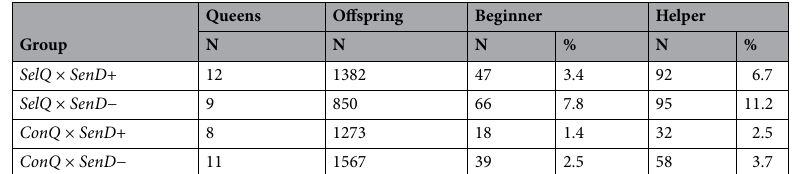
Table 1. Grouping considering queen’s origin and drone’s olfactory sensitivity. Summary of the number (N) of inseminated queens per group and their offspring (worker bees). Displayed are furthermore the number of beginner and helper bees in each group (N) and the corresponding equivalent in percent per group